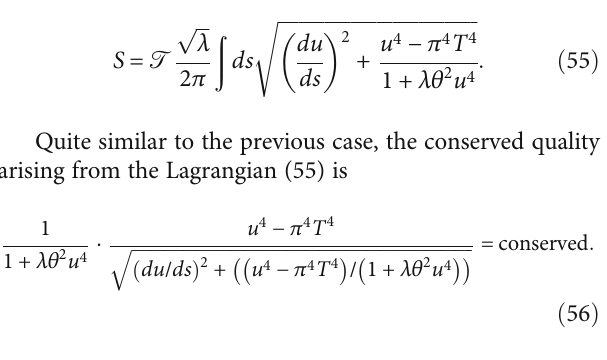
Figure 4: The plot indicates the e ff ective potential (in the presence of external electric fi eld) v/s the interquark separation. The values used are m = 1 and λ = 4 π 2 . The green line indicates r = 0 : 9 , blue line for r = 0 : 95 . The parameter r is the ratio of the applied fi eld to its threshold value. Note that the maximal height of the potential barrier decreases as noncommutativity increases. The red line which exhibits the threshold behavior stands for r = 1 : 0 , and cyan for r = 1 : 05 shows catastrophic decay of is positive for r < 1 . However, at u = 0/ L ⟶ ∞ , the slope of 0